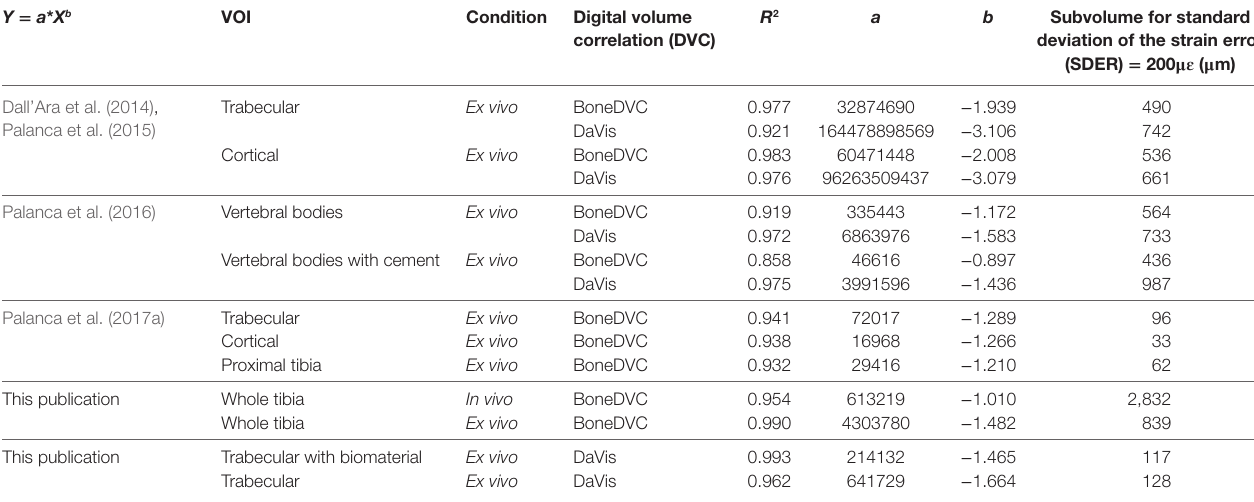
TaBle 3 | Coefficients of power law regressions ( a , b ) and the coefficient of determination ( R 2 ) between the standard deviation of the error (SDER) and the “subvolume” size for the results obtained in the different studies reported in this manuscript. Y = a * X b